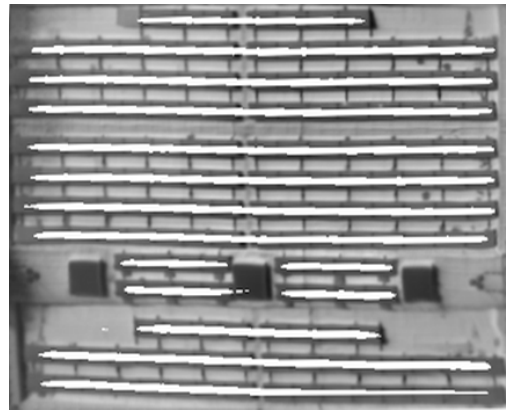
Figure 13. Searching for the template cell in the ortho image. White pixels are marked as possible good correlation with a cor- relation coefficient >